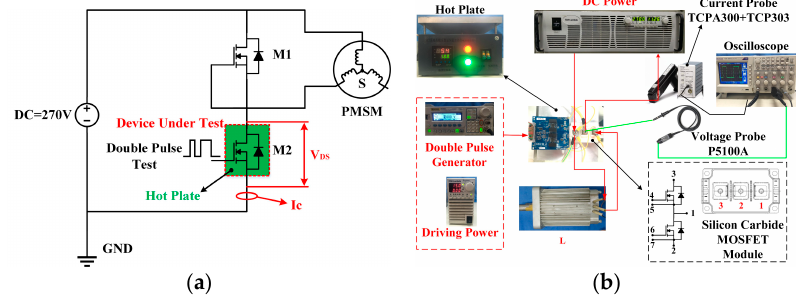
Figure 1. DPT test bench. ( a ) Simplified DPT circuit; ( b ) Actual components in the test bench.